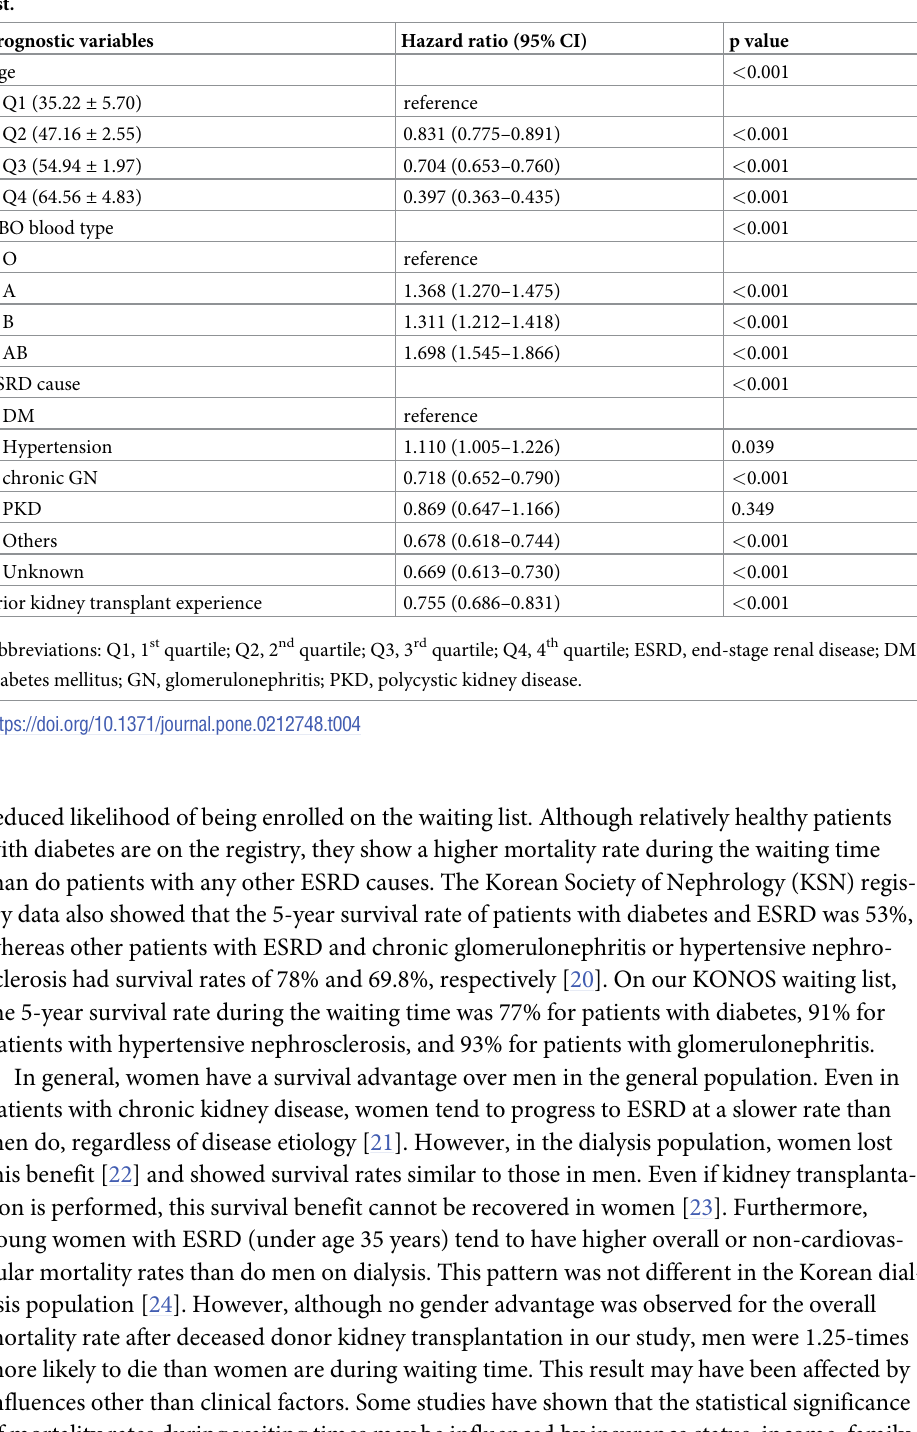
Table 4. Multivariate regression analysis of the probability of receiving a deceased donor kidney on the waiting